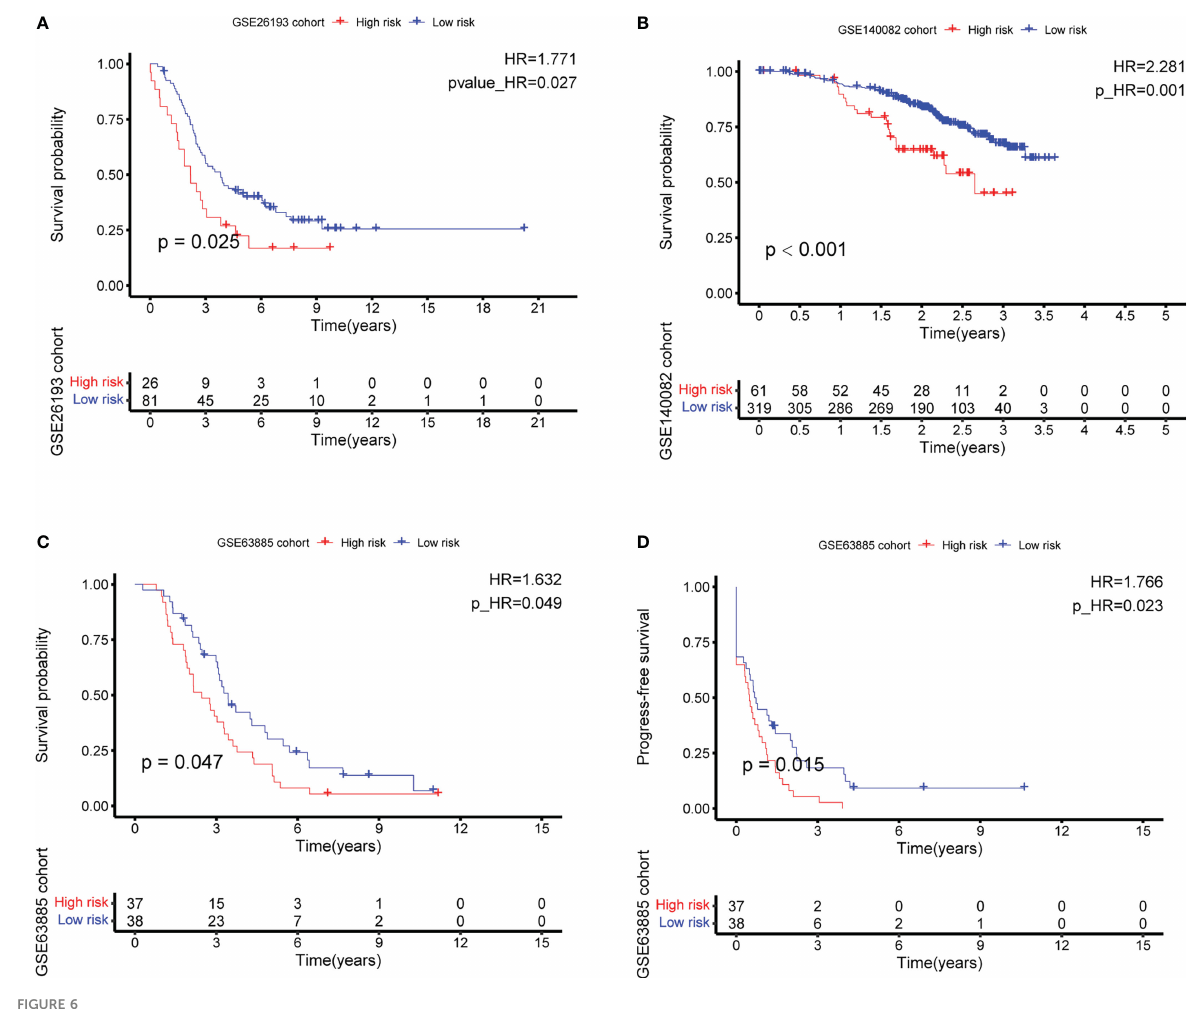
Figure 8A. The detailed differential genes information was in Supplementary Table 7. GSEA software was used to search for GO and HALLMARK terms across the whole TCGA dataset in high-risk and low-risk groups with all genes